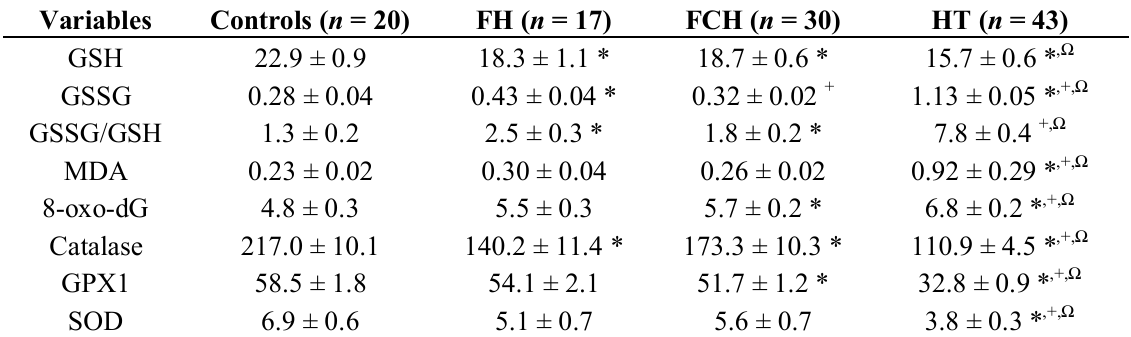
gender and Body Mass Index. GSH: reduced glutathione (µmol/mg protein); GSSG: